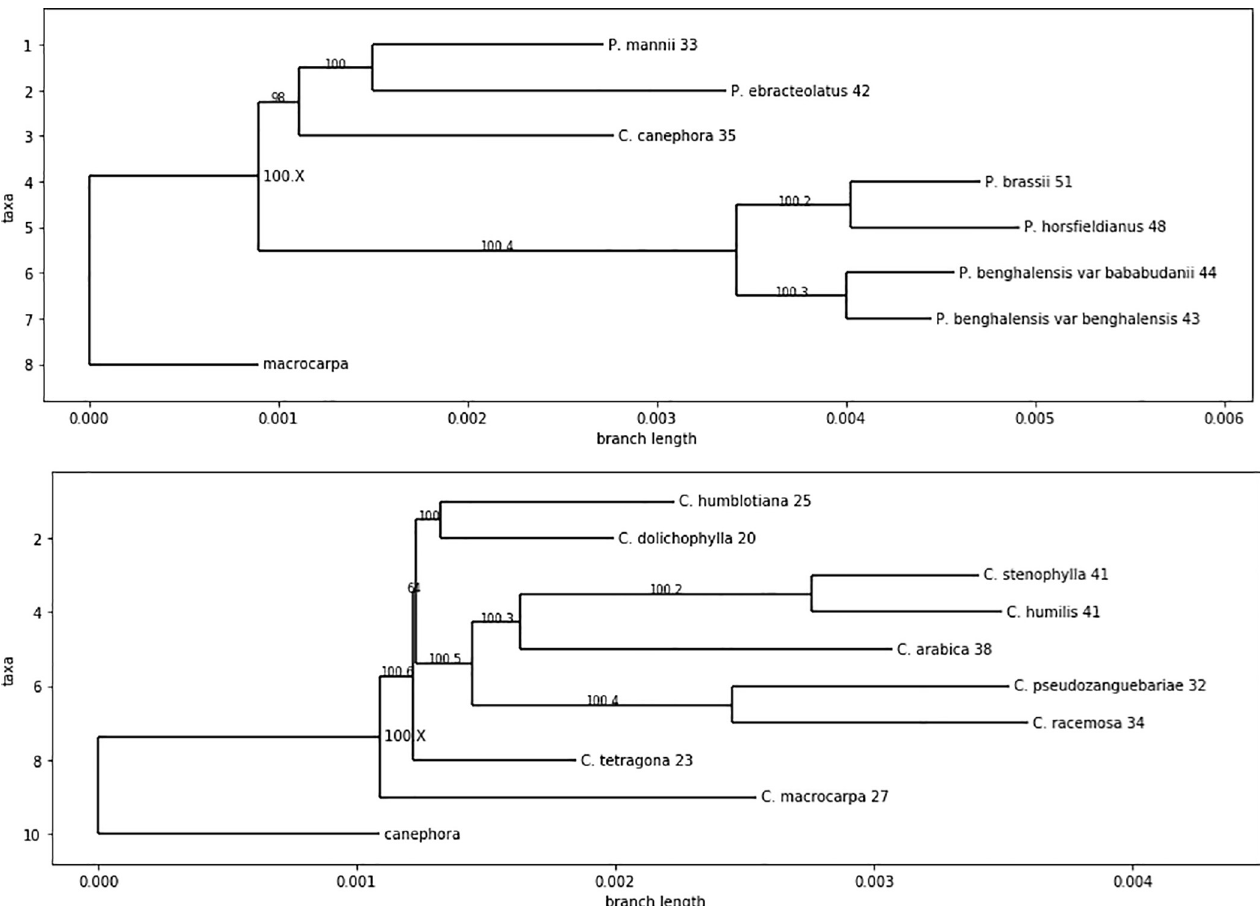
Fig 9. Phylogenetic tree showing the number of mutated genes per species. Phylogenetic tree with the number of mutated genes per species when compared to the ancestor (numbers next to the species names) of the clade (A)- Clade 1 ( Psilanthus ); (B)- Clade 2 ( Coffea ). Branch values are bootstraps according to the maximum likelihood phylogenetic reconstruction. A suffix has been added to provide unique names to ancestral